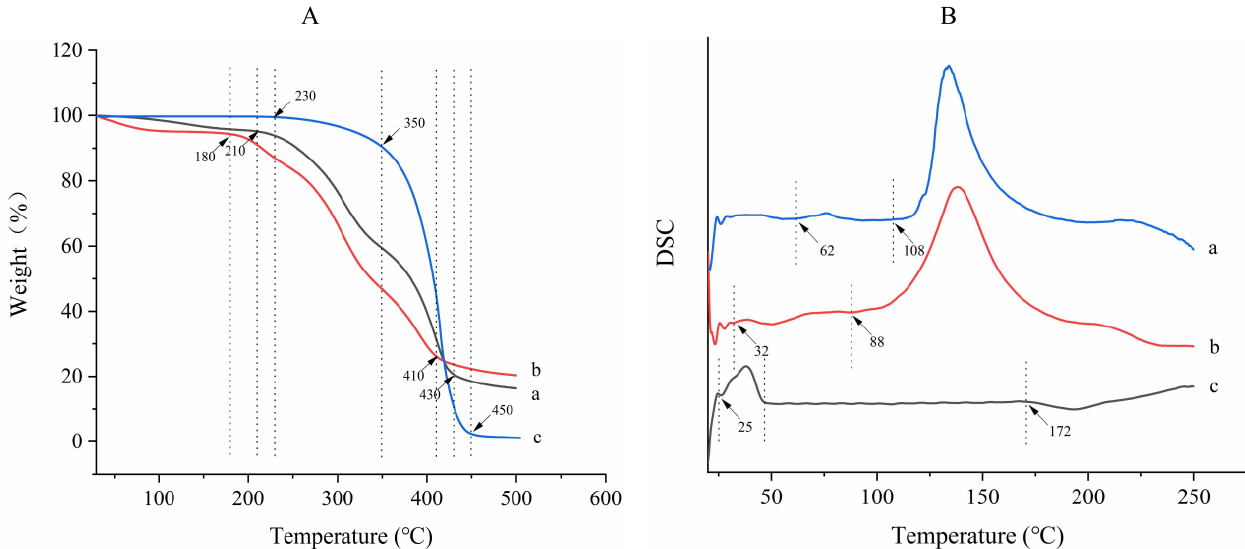
Figure 4. Thermogravimetric spectra ( A ) and differential scanning calorimetry spectra ( B ) of GLOM (a), the mixture of GLO and dried KGM/SPI wall (b) and GLO (c).